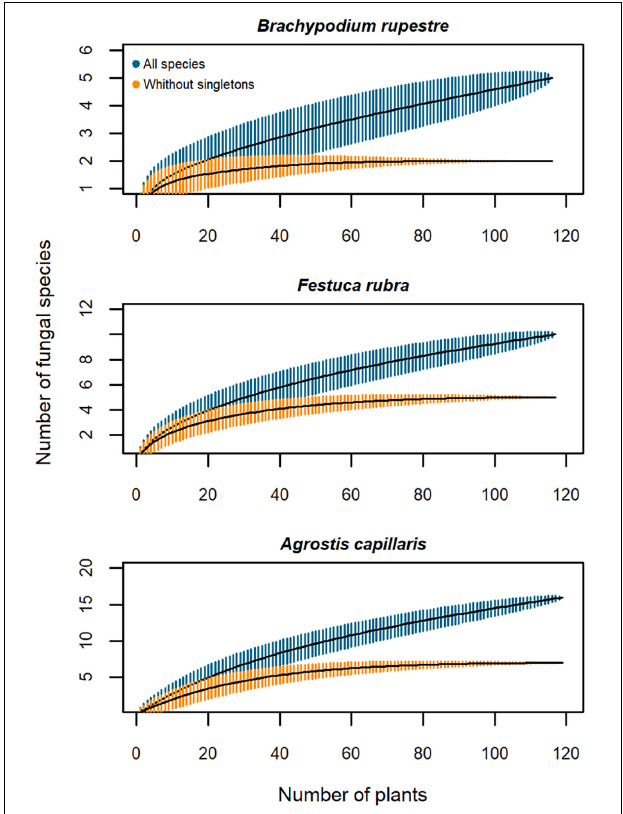
FIGURE 8 | Species-accumulation curves of fungal endophytes from Brachypodium rupestre , Festuca rubra and Agrostis capillaris shoots from high-diversity grasslands. Black line, based estimator of the total number of species; shaded zone, standard deviation; dark blue, all species included; orange, excluding singleton species.